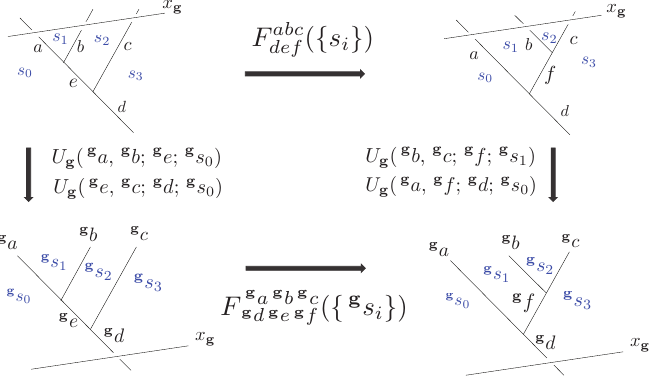
Figure 12: g action on the F -symbol diagram. All lines are assumed to be directed with arrows pointing